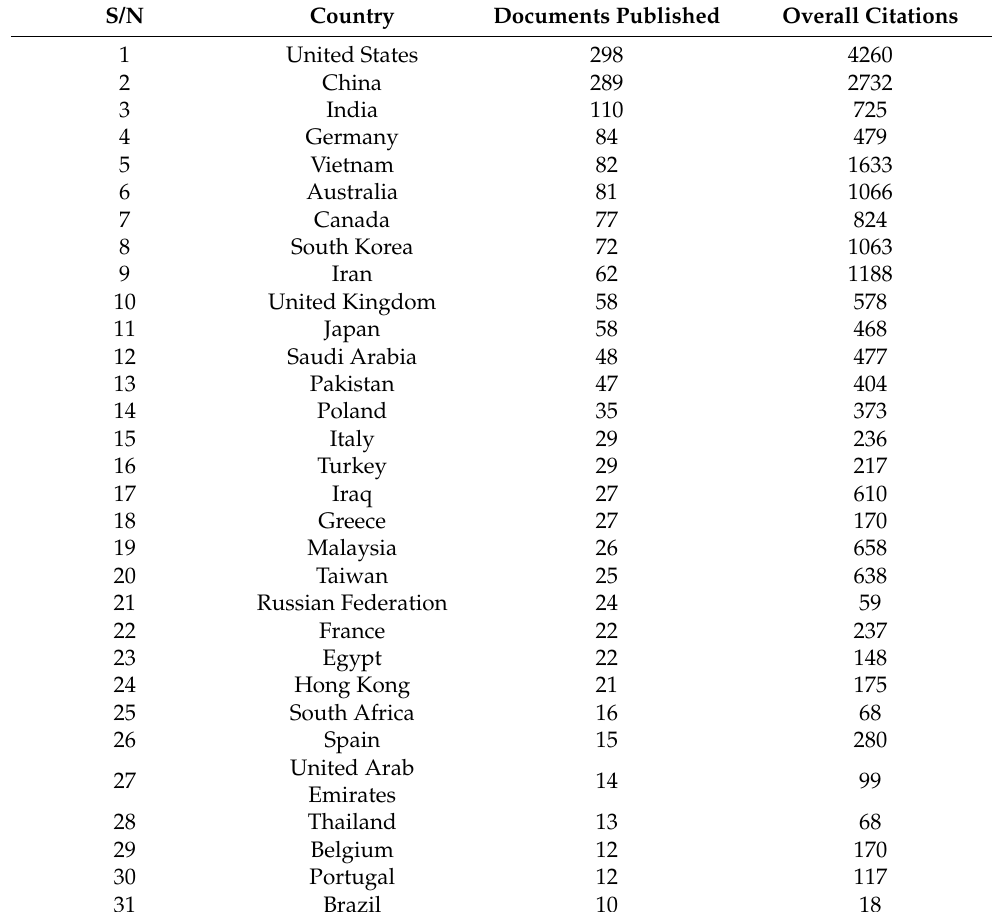
Table 5. List of countries that presented at least 10 papers in the subject research domain from 2001 to May